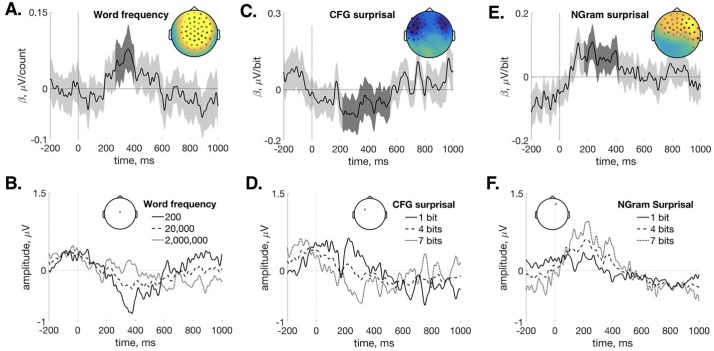
Whole-head regression results.β coefficients (M ± CI95) and model-reconstructed ERPs. (A) Regression time-series for log-transformed word frequency fit against content-word measurements. Dark grey shading indicates significant time-points and the inset shows significant channels and coefficient averages across significant time-points. (B) Estimated content-word ERP for three word frequency values ranging from low (200 corpus counts) to high (2,000,000 corpus counts) from a represenative central channel (inset) shows a classic N400 effect. (C) Regression time-series for hierarchical CFG surprisal fit against content-word data (inset and shading as in (A)). (D) Estimated content-word ERP for three CFG surprisal values from a representative channel (inset). (E) Regression time-series for sequential Ngram surprisal fit against function-word data (inset and shading as in (A)). (F) Estimated function-word ERP for three Ngram surprisal values from a representative channel (inset).